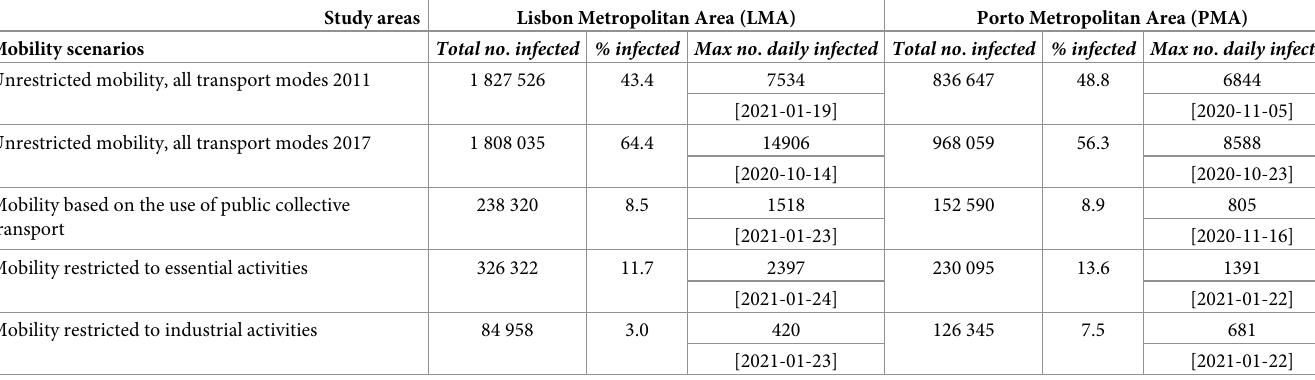
Table 2. Results on infected cases, obtained from the simulations with different mobility scenarios, for LMA and PMA. Study